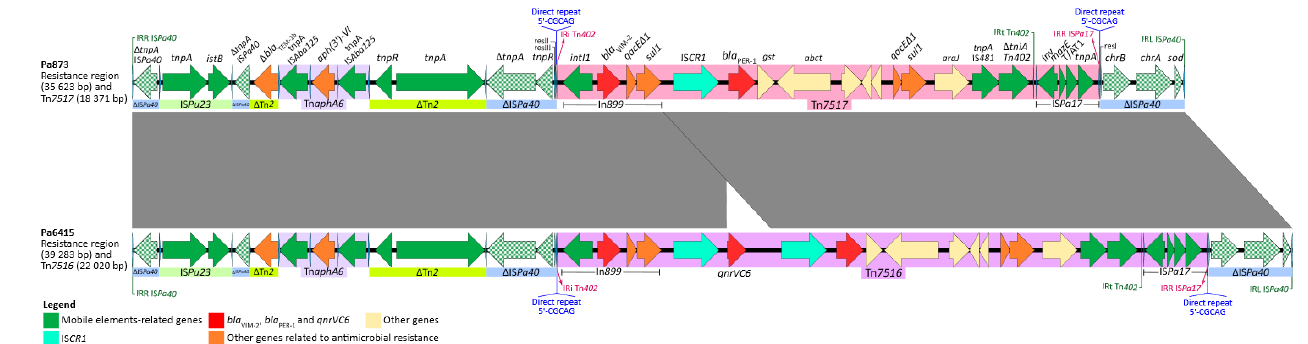
Figure 1. Linear map of resistance regions and Tn 7517 and Tn 7516 of Pseudomonas aeruginosa Pa873 (GenBank acc. No. OP329418) and Pa6415 (GenBank acc. No. OP329419), respectively. Homologous segments ( ≥ 99% identity) are shown as gray blocks. Genes are represented by arrows and colored according to their function, as shown in the legend.